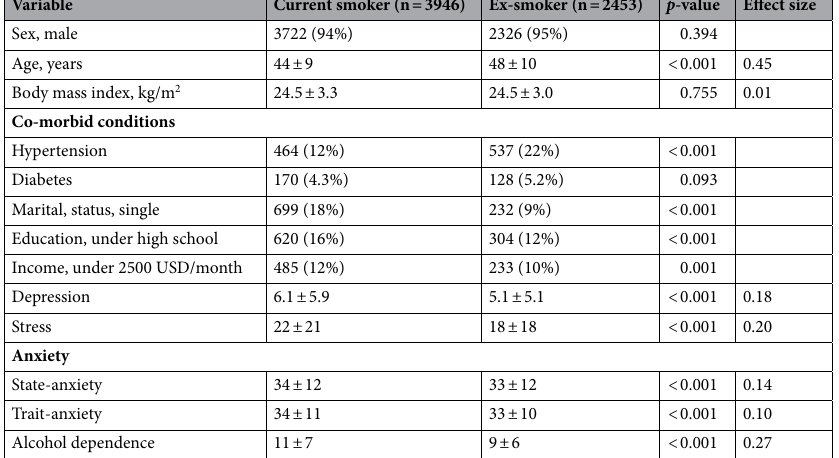
Table 2. Clinical characteristics and mental health in smokers. Data are presented as mean with standard deviation or number (%).